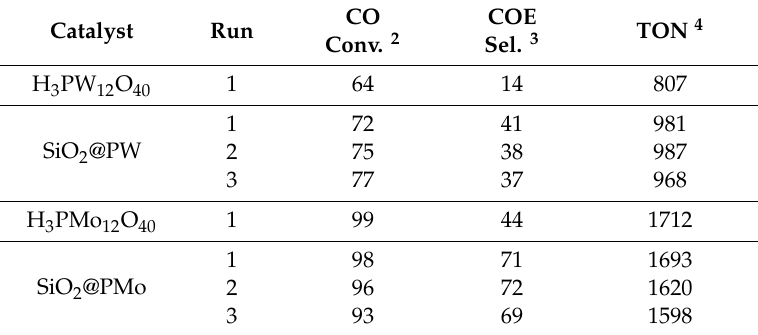
Table 3. Relevant data for the catalyzed epoxidation of CO 1 .